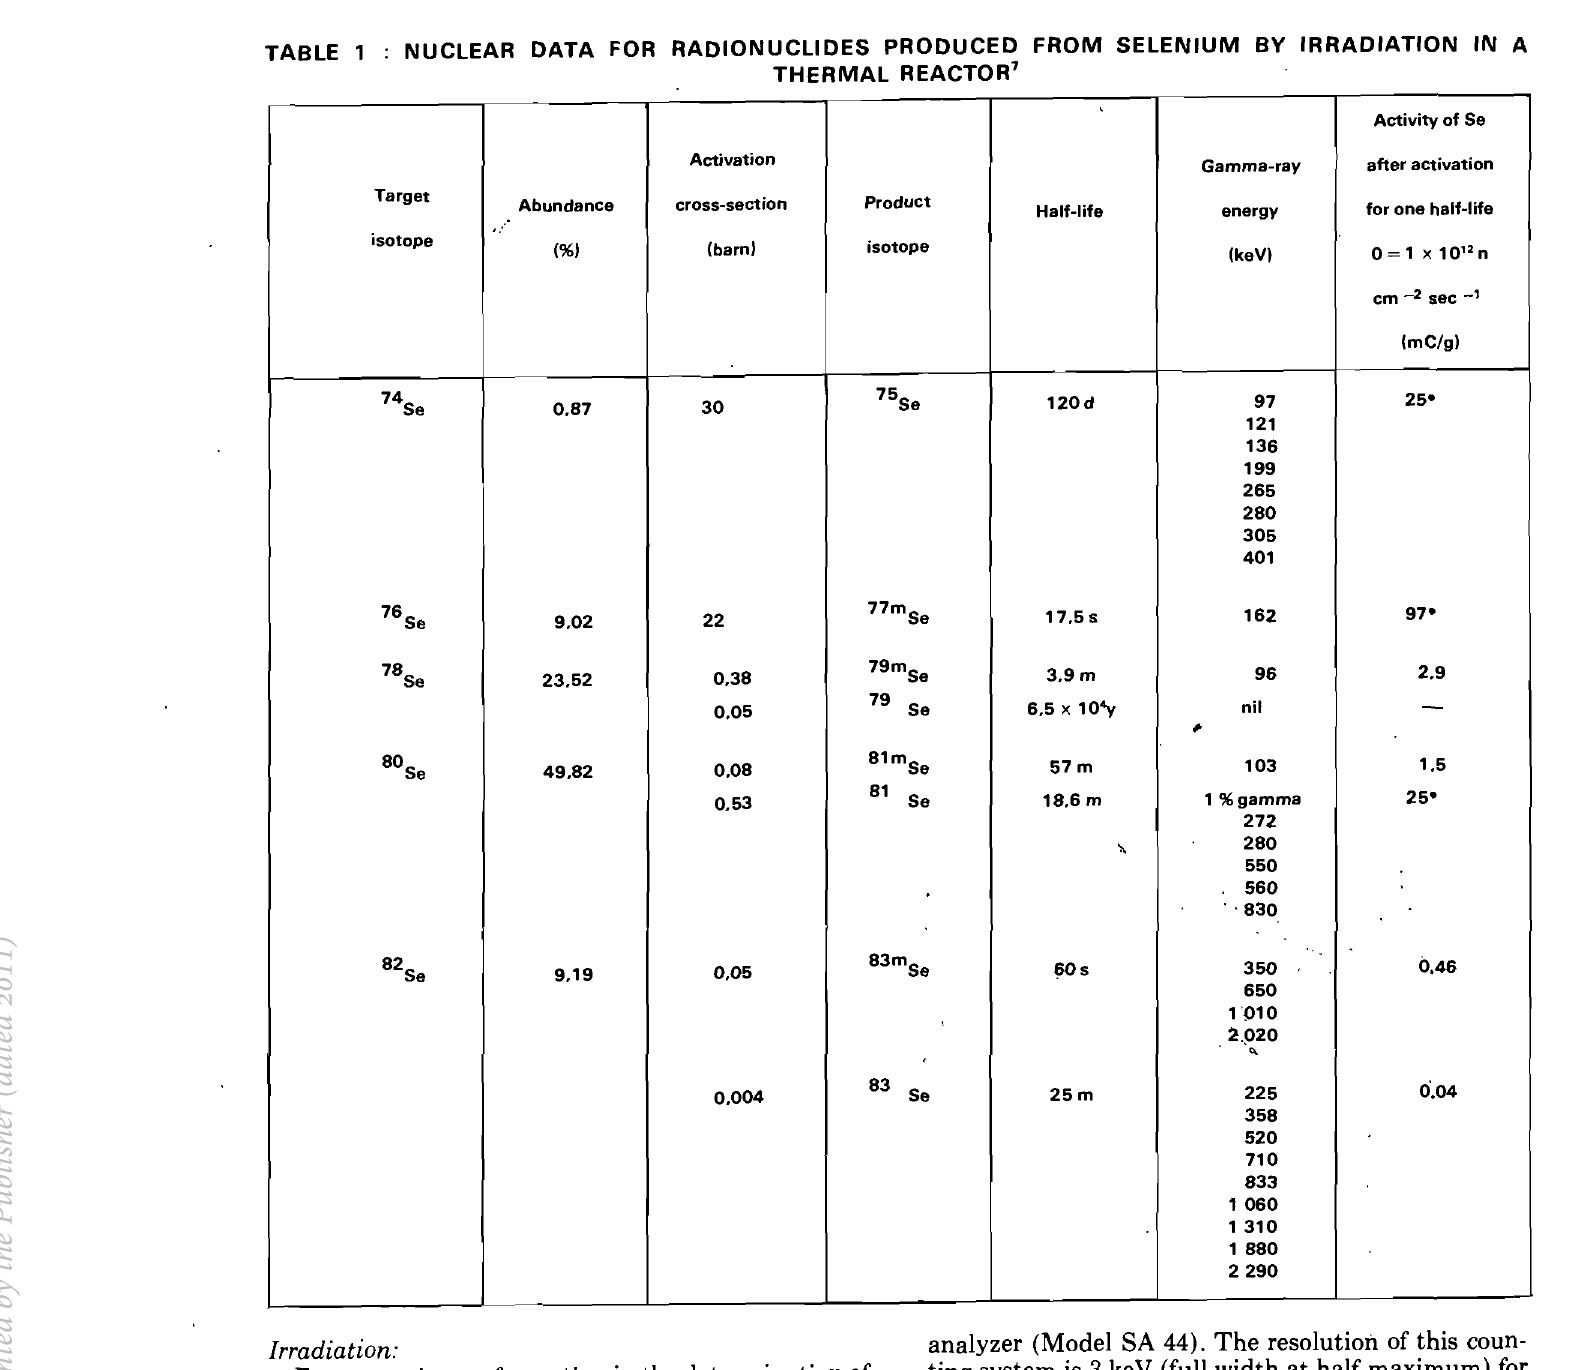
NUCLEAR DATA FOR RADIONUCLIDES PRODUCED FROM SELENIUM BY IRRADIATION IN A THERMAL REACTOR 7 Activation Gamma-ray after activation Abundance